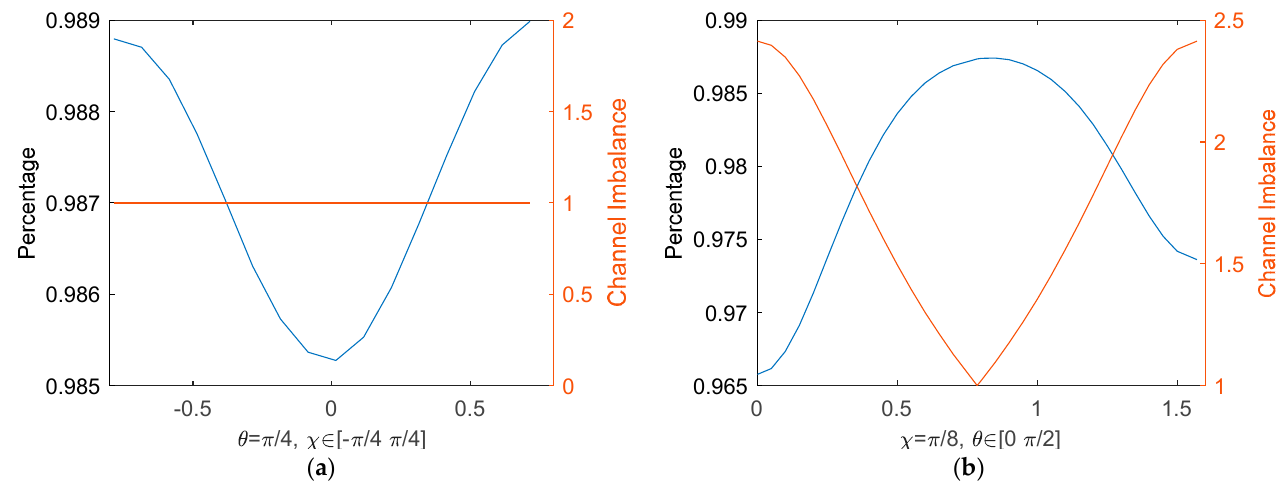
Figure 4. Percentage of pixels (the Fuzhou data) that satisfy the bound constraint for two types of CP cases. ( a ) Transmit waves with balanced amplitudes, ( b ) transmit waves with imbalanced amplitudes.